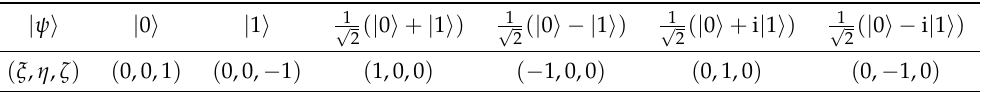
Table 1. Correspondence between qubits | ψ (cid:105) = cos θ